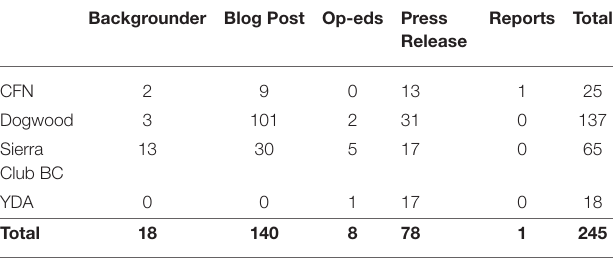
TABLE 1 | Communications materials produced by sample organizations between 2011 and